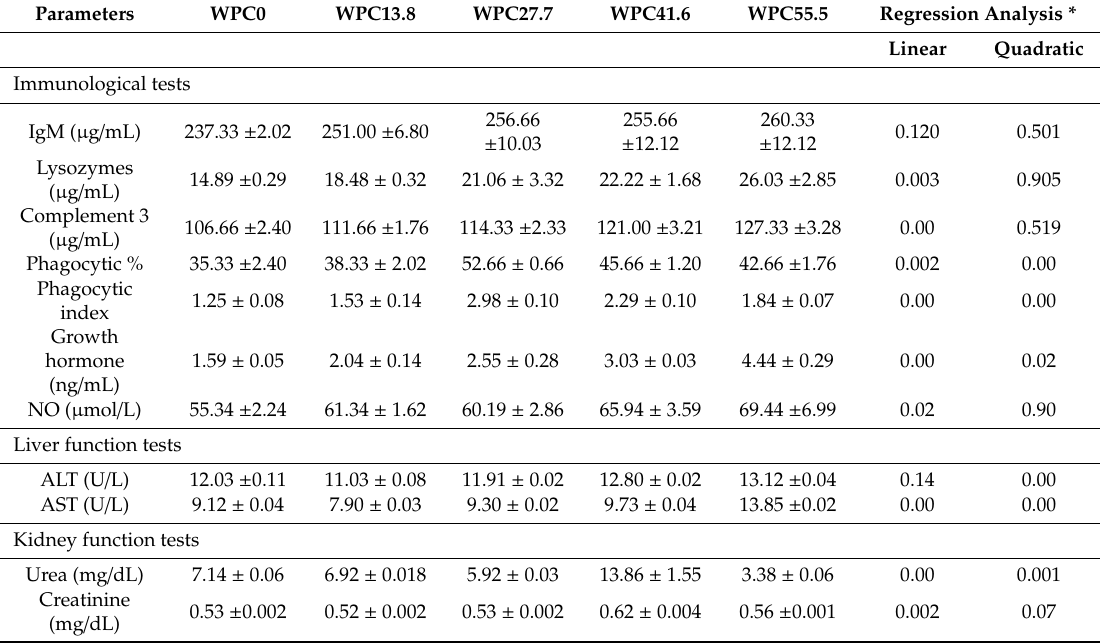
Table 3. The e ff ect of partial replacement of fish meal with whey protein concentrates on immune status, blood levels of growth hormone and nitric oxide, and kidney and liver function tests of Nile tilapia fingerlings at the end of the experiment.